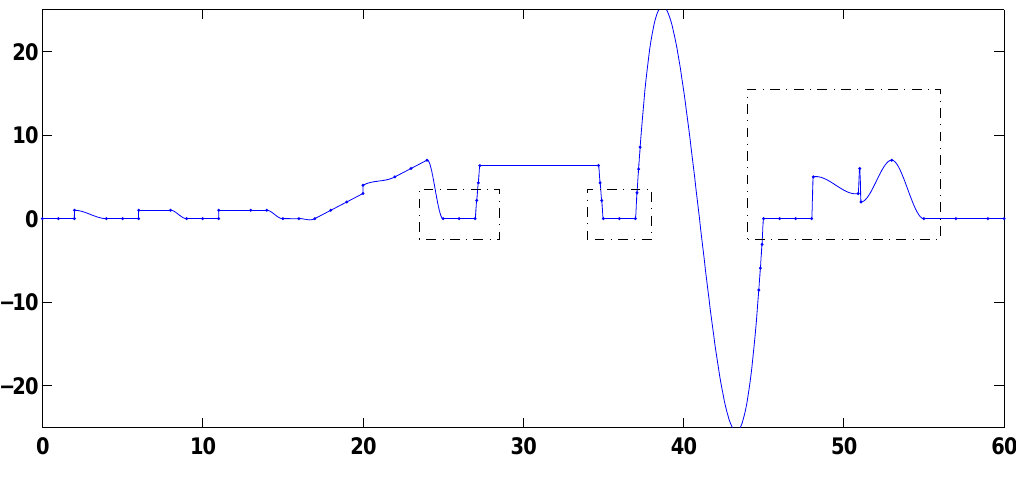
Figure 10 . Function-value-based global L